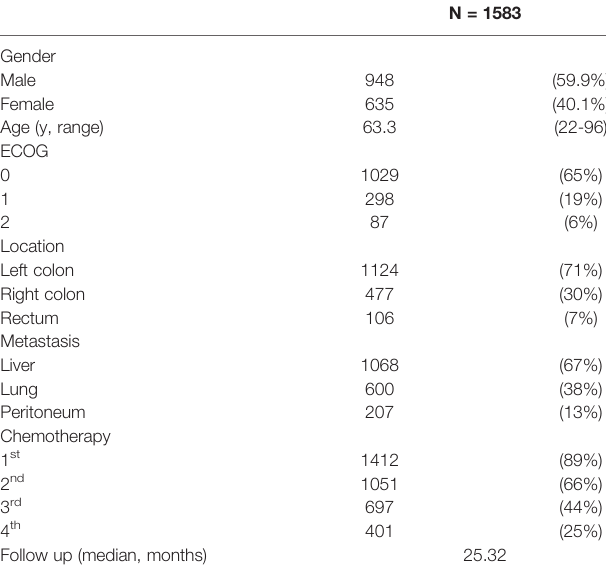
TABLE 1 | Baseline characteristics of the patients included in the